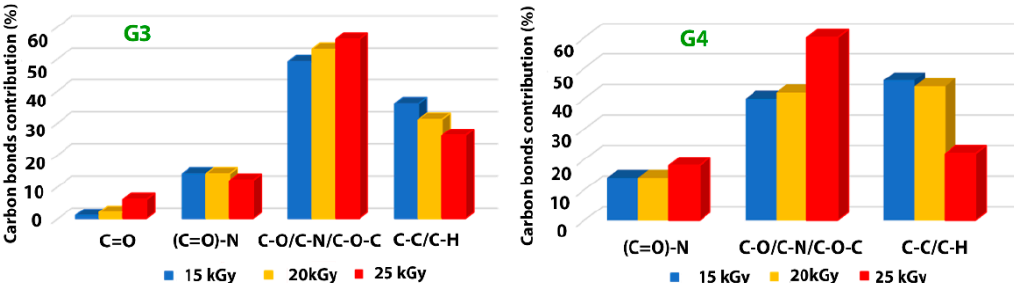
Figure 8. Dependence of the various carbon-related bonds on the irradiation dose for G3 hydrogels and respectively G4